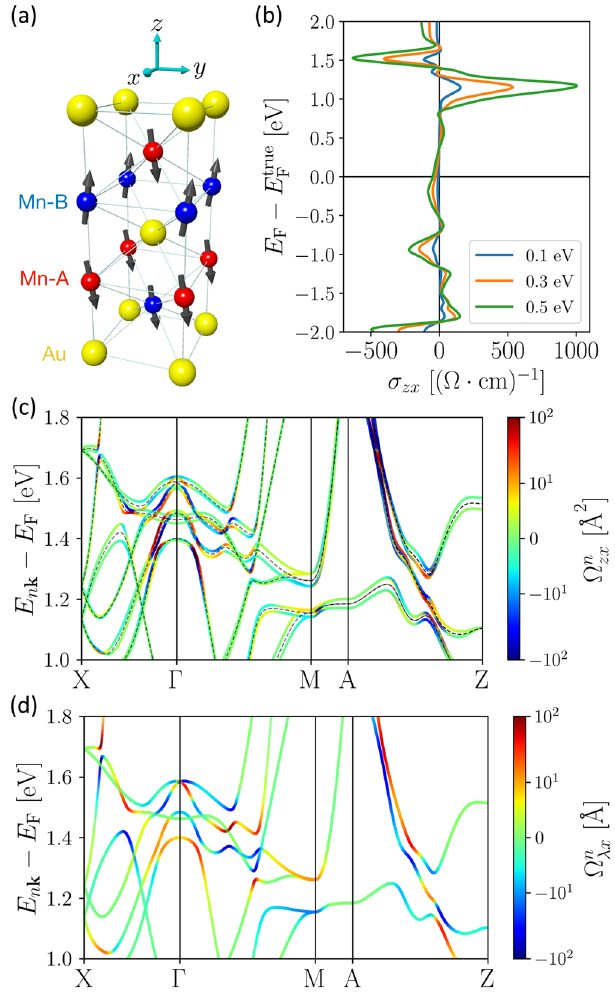
Fig. 4 Chiral Hall effect and staggered mixed Berry curvature in Mn 2 Au. a Crystal structure of Mn 2 Au with Mn atoms in sublattices A and B denoted with red and blue balls, respectively, and Au atoms shown with yellow balls. The canting of spins, initially oriented along z , is induced by applying an exchange fi eld along y . b Fermi energy dependence of the chiral Hall conductivity for different strength of the exchange fi eld (100 meV corresponds to 2° canting). c Band distribution of k-space Berry curvature Ω n + 1.0 eV and + 2.0 eV above the Fermi zx for electronic states between energy, where the chiral Hall effect is pronounced, for the canting of + 2°. Dashed line indicates the doubly degenerate electronic band structure in the absence of canting. The effect of opposite canting is identical, with the sign of the Berry curvature of each band reversed. d Band distribution of staggered mixed Berry curvature Ω n λ x for electronic states without canting shown with dashed line in c . Note that Ω n λ x is identical for each of the doubly degenerate bands. The correlation between the chiral Hall effect and staggered mixed Berry curvature is